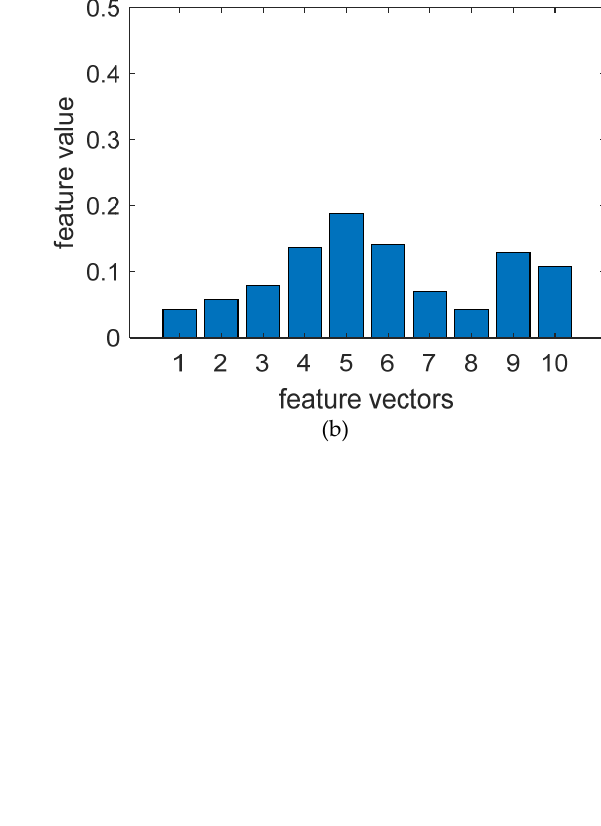
Figure 7. LBP-extracted image textures of forest fire images: ( a1 ) forest image without fire; ( a2 ) LBP- extracted image textures of forest image without fire; ( b1 ) forest image with fire; ( b2 ) LBP-extracted image textures of forest image with fire; ( c1 ) forest image with fire-like interference; ( c2 ) LBP-ex- tracted image textures of forest image with fire-like interference.